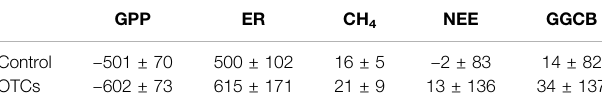
TABLE 2 | Modeled annual cumulated gross primary production (GPP; gC m − 2 yr − 1 ), ecosystem respiration (ER; gC m − 2 yr − 1 ), CH 4 emissions (CH 4 ;